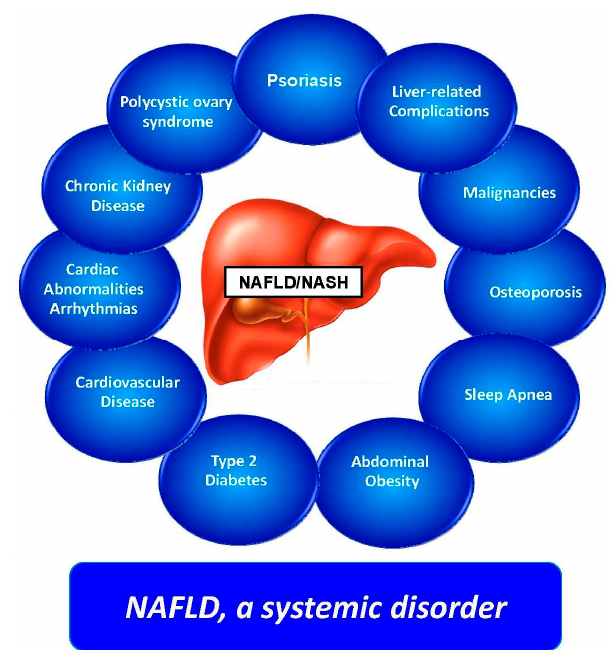
Figure 1. Nonalcoholic fatty liver disease (NAFLD) as a systemic disorder. This figure depicts the ever enlarging protean clinical spectrum of NAFLD. The variety and heterogeneity of the organ systems involved in patients with NAFLD witnesses the systemic nature of this common liver disease. (Modified from [36]).